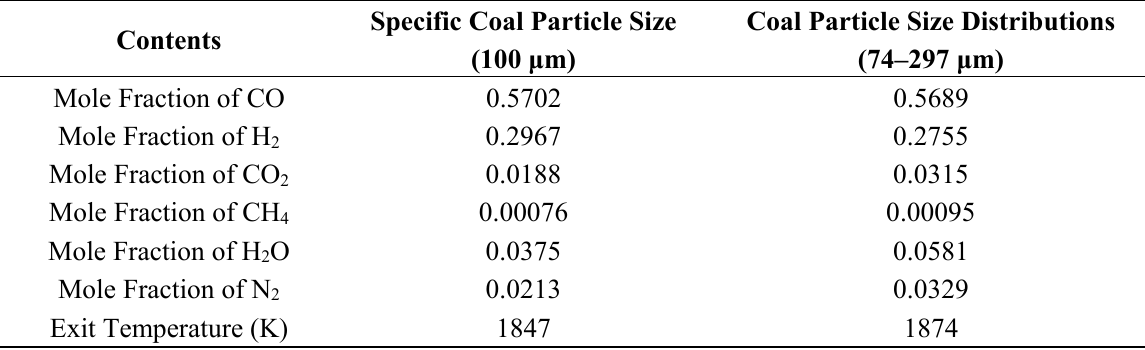
Table 4. Effect of coal size distribution on temperature and mole fractions of product gases at the gasifier exit (Feeding rate of coal = 28.35 kg/s).